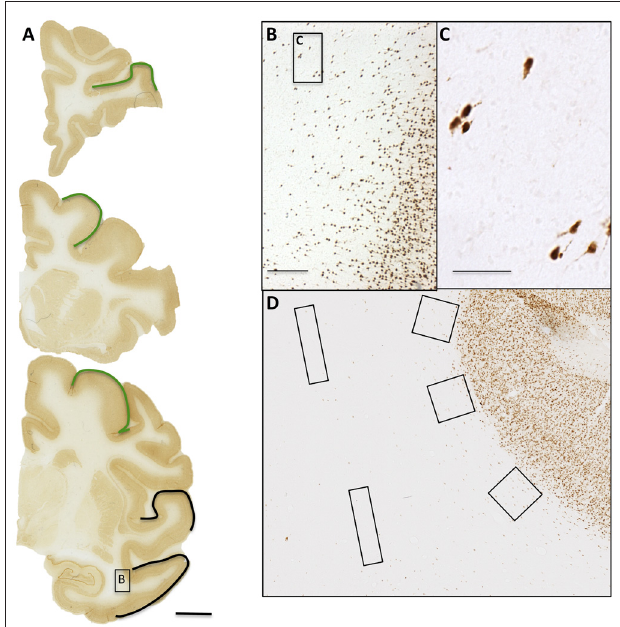
FIGURE 1 | WMNs are visualized by Neu-N. (A) Three coronal sections from the frontal, parietal, and temporal areas. Regions of interest (ROIs) are identified by outline (top and middle: frontal; bottom: parietal in green and temporal in black). (B) Representative field of Neu-N immunolabeled neurons, from the boxed temporal region in the coronal section at bottom. (C) Higher magnification from the box in (B) . (D) Representative placement of three counting boxes (400 × 400 µ m) along the superficial white matter (WM) and two rectangles (800 × 200 µ m) within the deep WM. Scale bars = 500 µ m in (A) ; 250 µ m in (B) ; 50 µ m in (C)